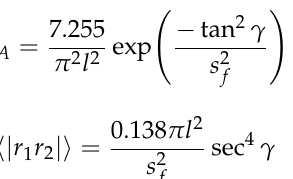
where l is the correlation length between surface points ζ ( x , y ) and ζ ( x’ , y’ ) separated by a horizontal distance r = [( x − x’ ) 2 + ( y − y’ ) 2 ] 1/2 and assuming a Gaussian distribution of the correlation coefficient as r → 0. The numerical constants in Equations (4) and (5) result from carrying out triple integral functions of ( ζ xx , ζ xy , ζ yy ); the details are provided in Barrick [5,6].